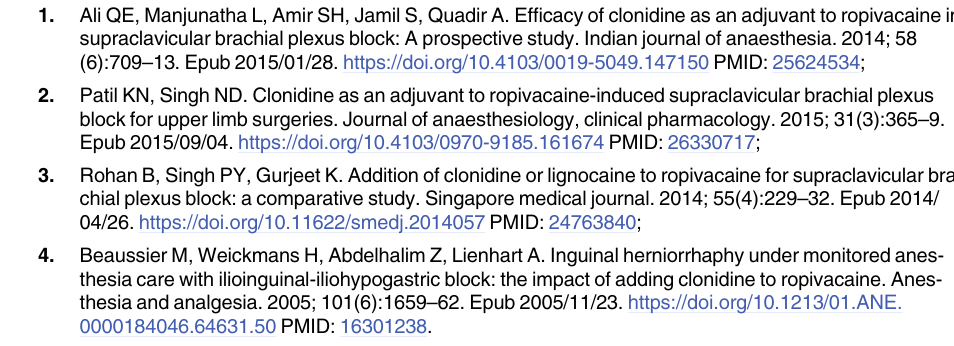
S1 Table. CONSORT 2010